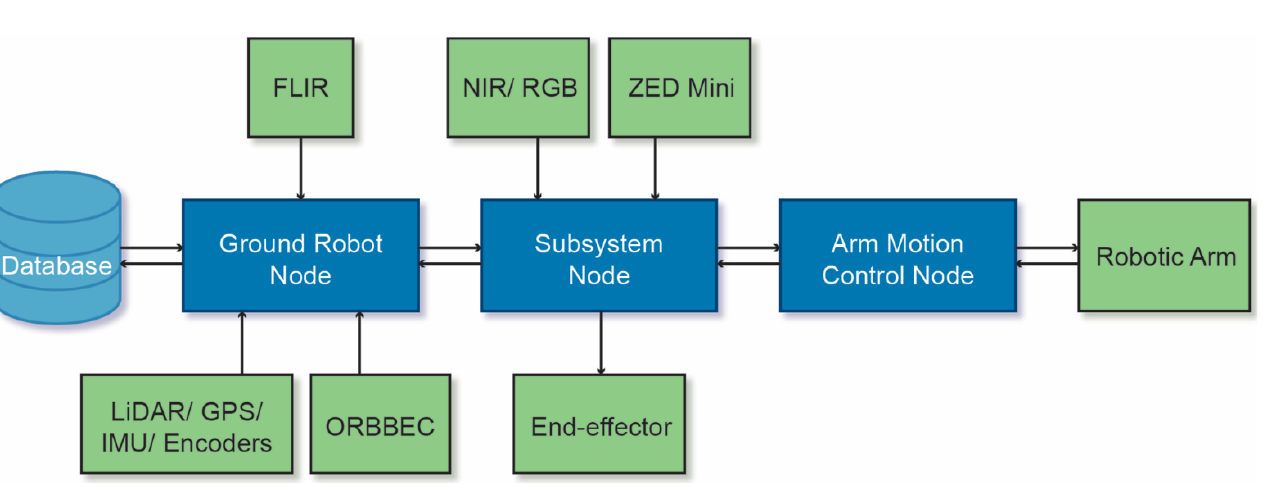
Figure 10. Hardware and software architecture of the